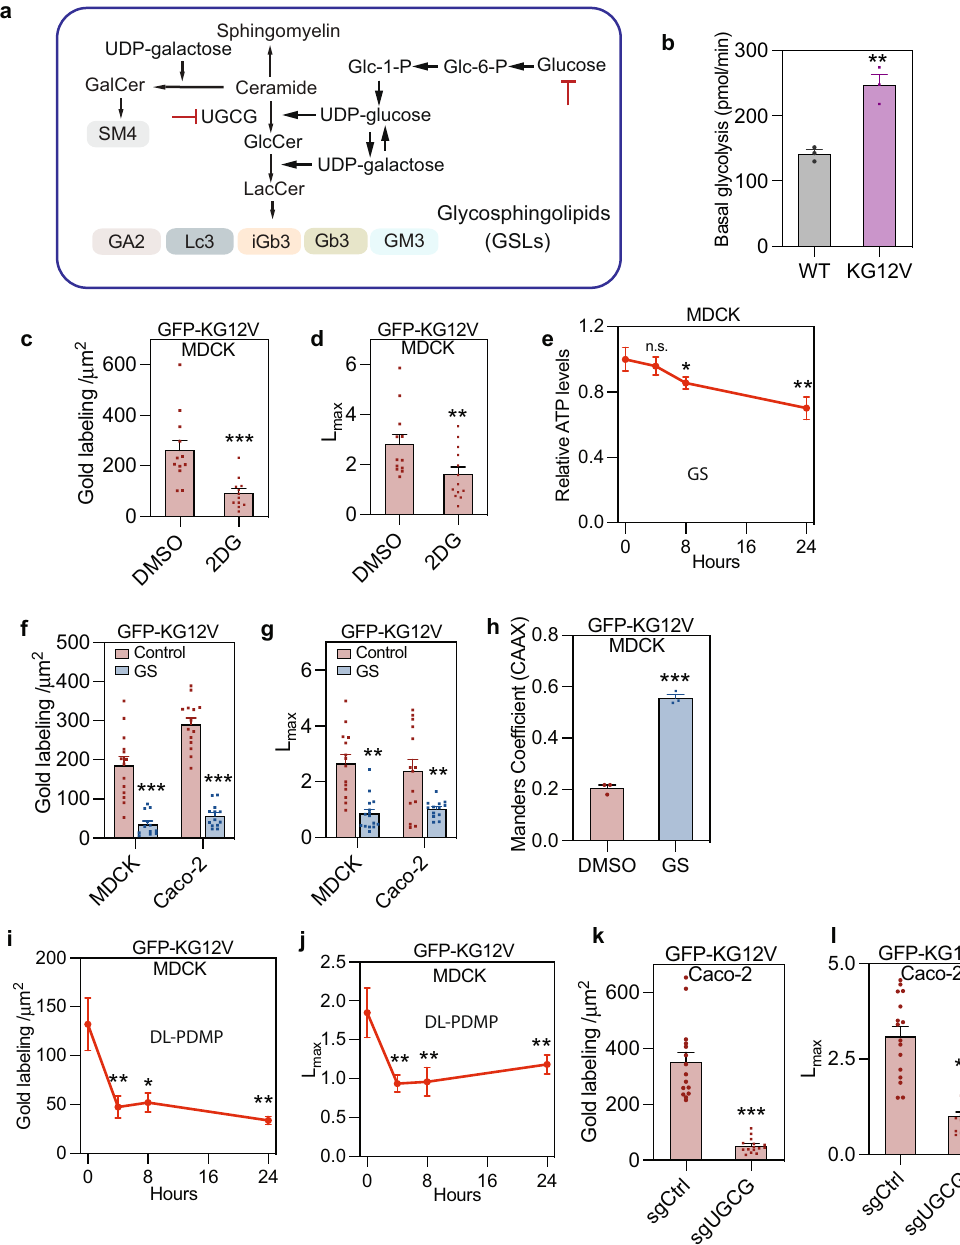
Fig. 1 | Suppressing glycolysis mislocalizes KRASG12V from the plasma mem- brane. a Diagram of GSL synthetic pathways. UGCG, UDP-glucose ceramide glu- cosyltransferase. b Basal glycolysis rate of WT and KRASG12V (KG12V) expressing MDCK cells measured in a Seahorse XF analyzer (±SEM, n =3 independent biolo- gical relicates, ** p <0.01). Time course of changes in 2DG (10mM)-treated MDCK cellsof:GFP-KRASG12V(KG12V)PMbindingquanti fi edbyEMasmeangoldlabeling density ( c ), and nanoclustering quanti fi ed as L max ( d ) ( n =12 PM sheets for each group).FortheDMSOcontroltimecourseseeFig.S1J – L.Timecourseofchangesin relative ATP levels for control ( t =0) and glucose-depleted (GS) MDCK-KRASG12V cells (±SD, n =3 wells, * p <0.05, ** p <0.01) ( e ). PM localization ( f ) and nanoclus- tering( g )ofKRASG12V-expressingMDCK( n =14forControl, n =12forGS)orCaco-